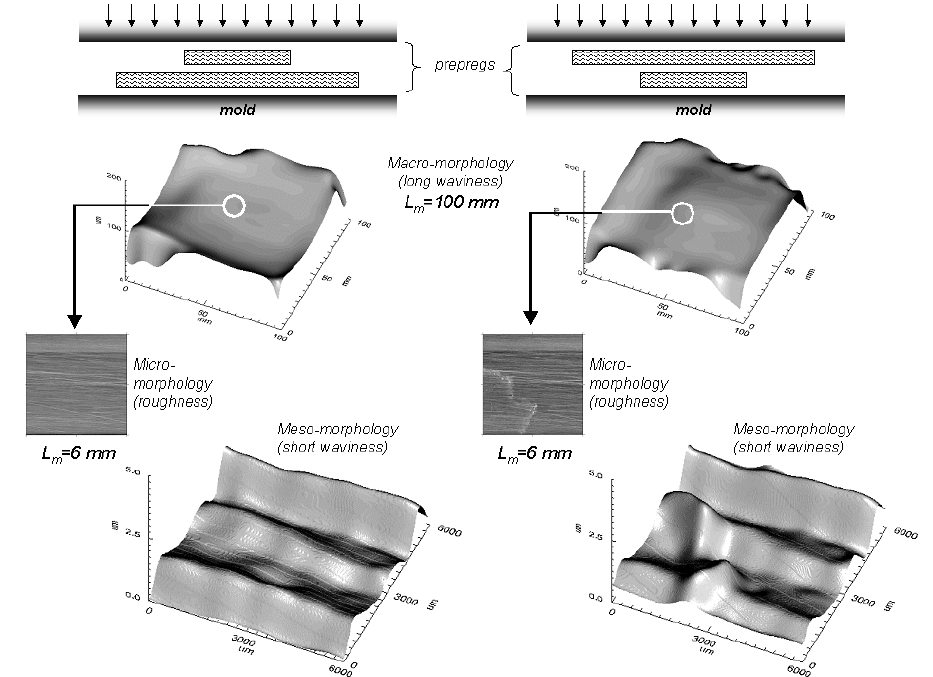
Figure 21. Effect of prepregs placement procedure on macro-, meso- and